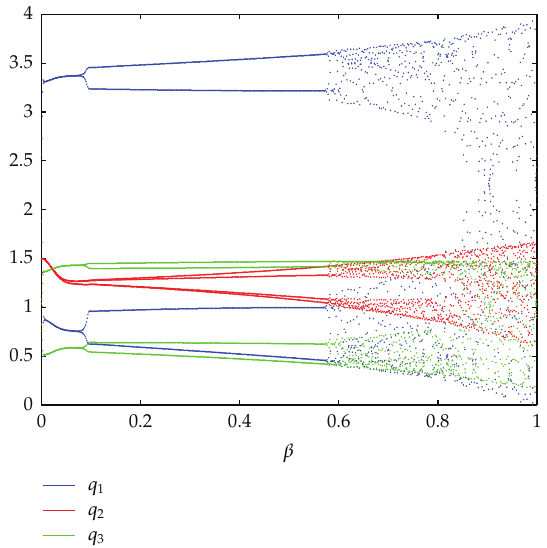
Figure 8: Bifurcation diagram with respect to β for α (cid:7) 21 .